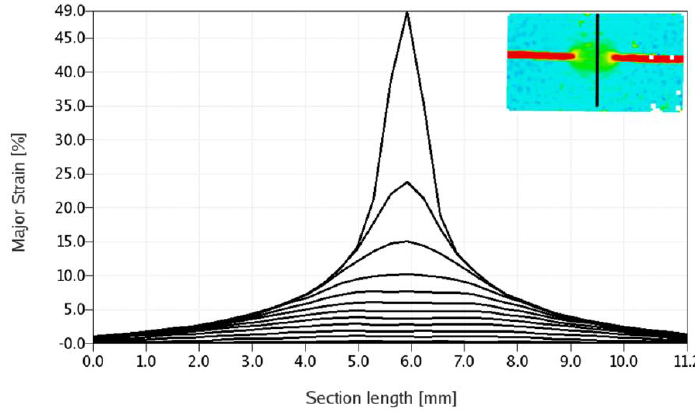
Figure 11. Major strain development along the section line in incremental stage